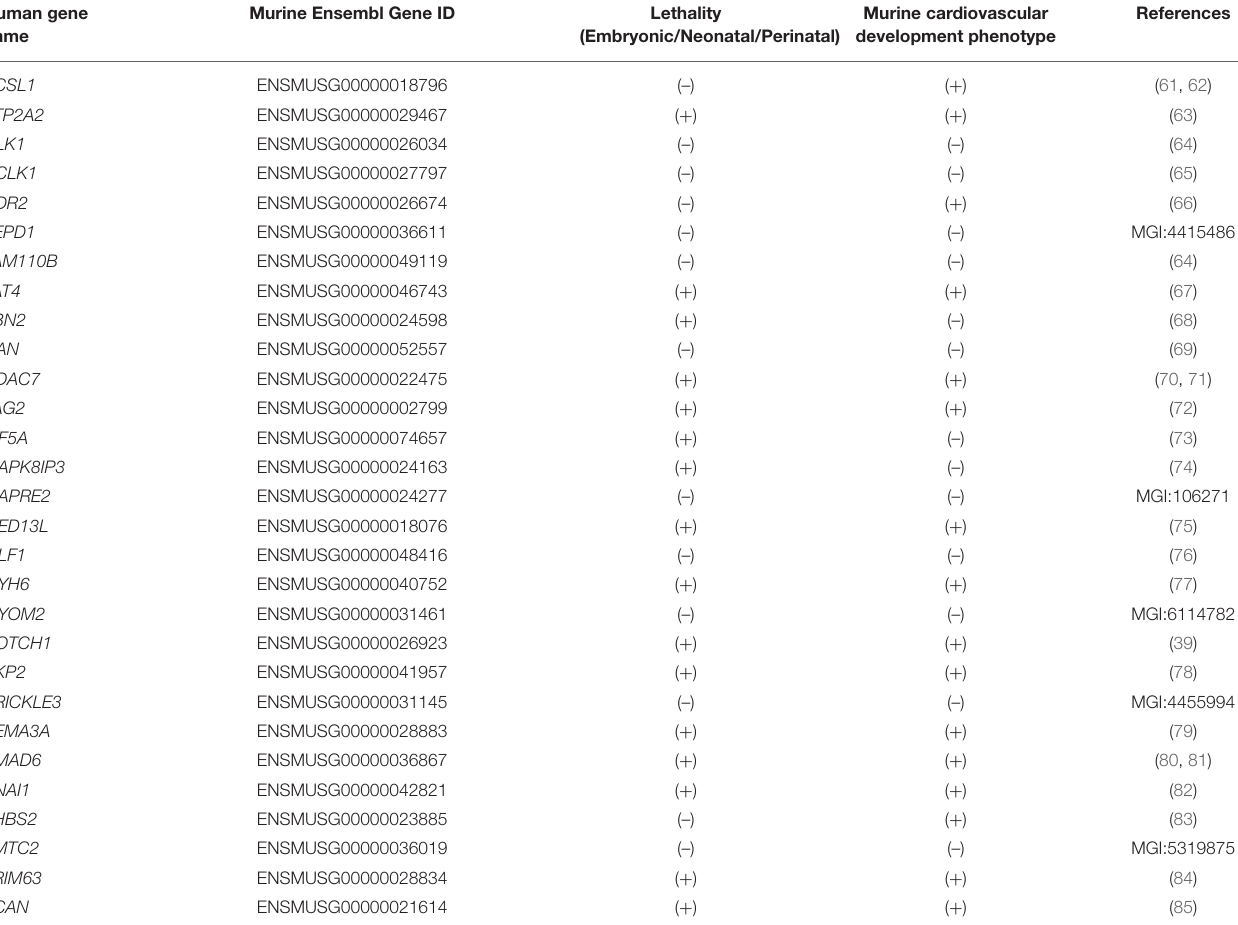
TABLE 1 | Overlap between DEG-HH and TOF-DN-MH gene